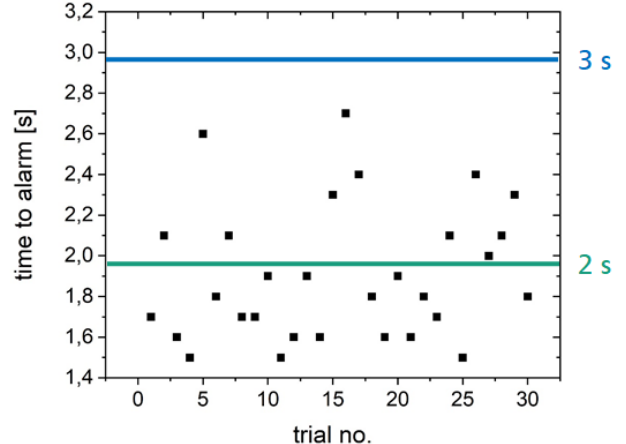
Fig. 6. 137 Cs with 0.5 µSv/h above background brought in front of the D3S via a step change. 3 s is the criterion for IEC SPRD and ITRAP+10 RIID testing, 2 s is the criterion for ITRAP+10 PRD testing.